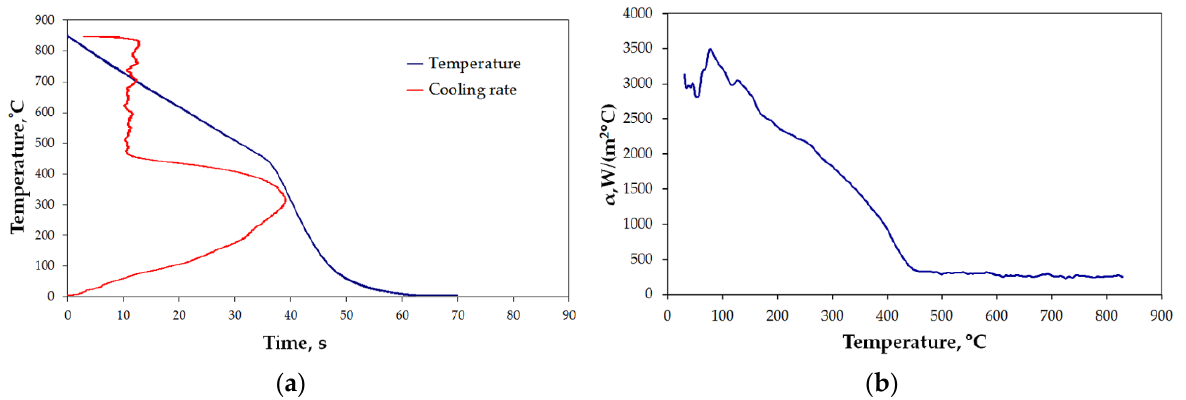
Figure 7. Results of measurement: ( a ) T = f( τ ) and v = f(T) , and ( b ) heat transfer coefficient for settings 2 (Table 1).